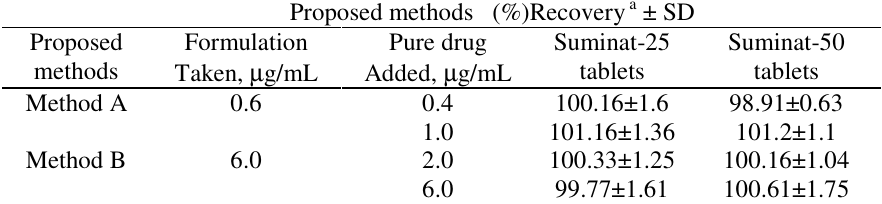
Table 3. Results of recovery experiments by standard addition method